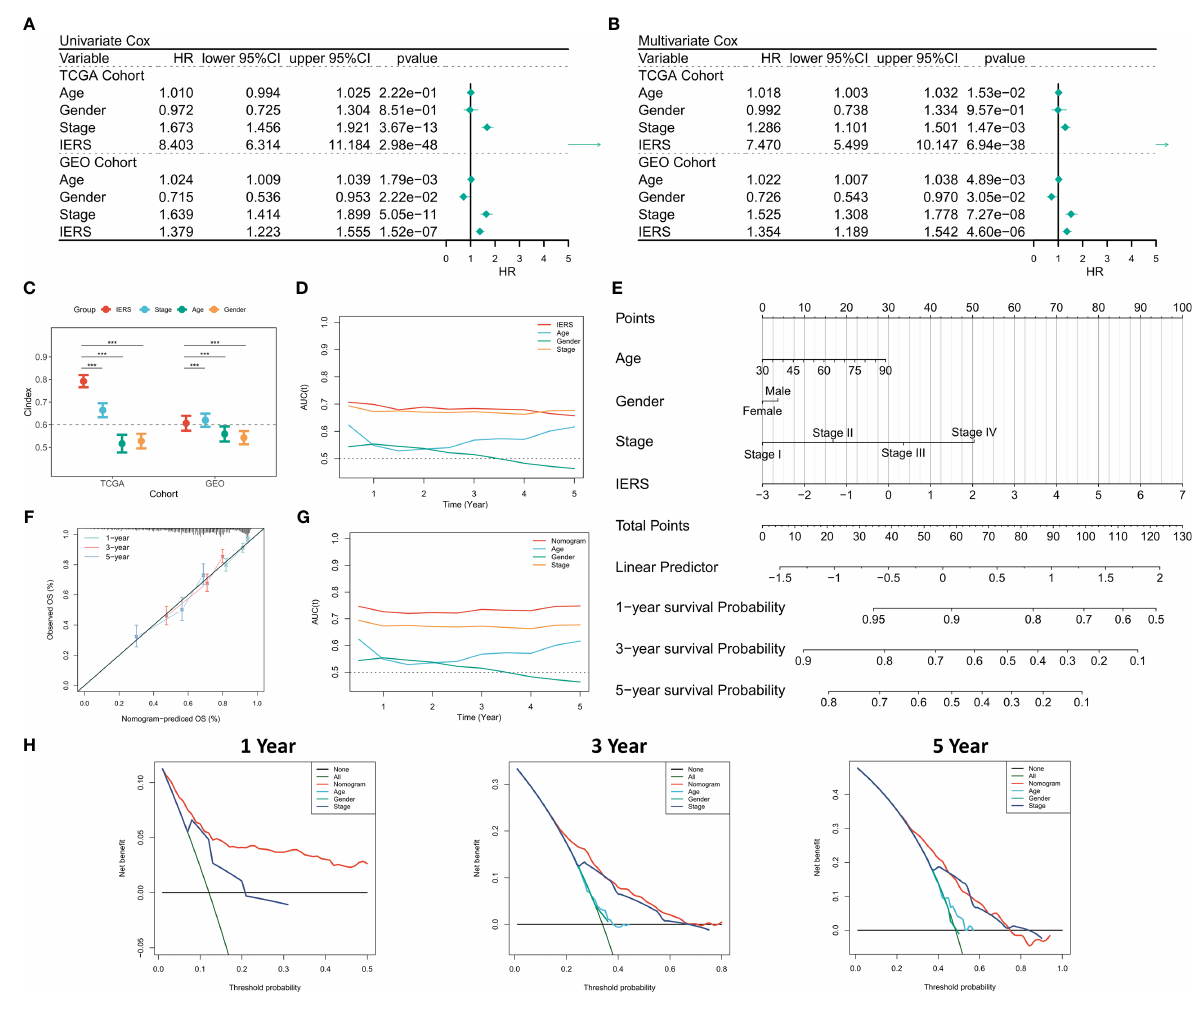
FIGURE 3 Evaluation of the IERS model (A) Univariate Cox regression analysis of OS in TCGA and meta-GEO cohorts; (B) Multivariate Cox regression analysis of OS in TCGA and meta-GEO cohorts. (C) Comparison of the performance of IERS and other clinical indicators. (D) timeROC curves for the IERS and clinical characteristics. (E) Construction of a nomogram based on the IERS. (F) Calibration curves for the nomogram. (G) timeROC curves for the nomogram and other clinical characteristics. (H) 1-, 3-, and 5-year DCA curves for the nomogram and other clinical characteristics.